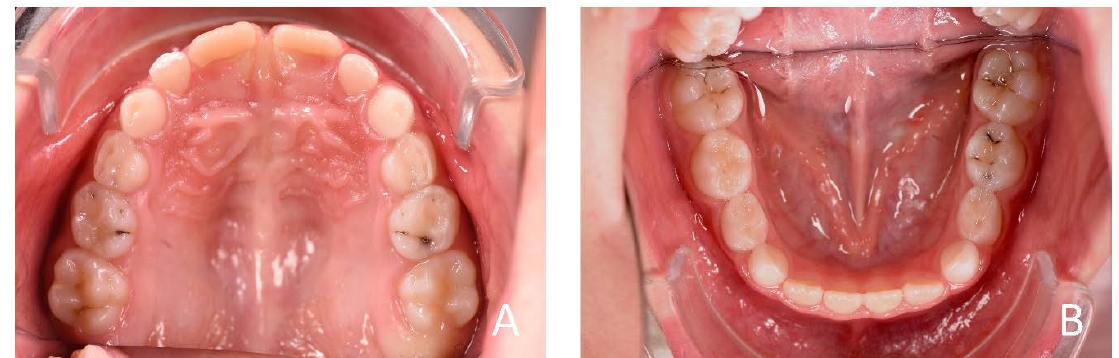
Figure 13. Initial occlusal photos of dental arches (7-year-old). ( A ) Upper arch; ( B ) lower arch.